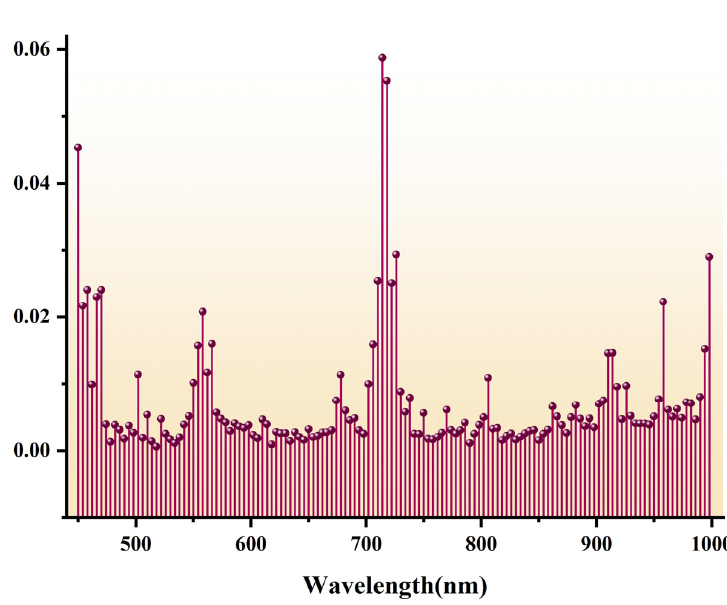
Figure 9. RF contribution rate evaluation results of SSR data.